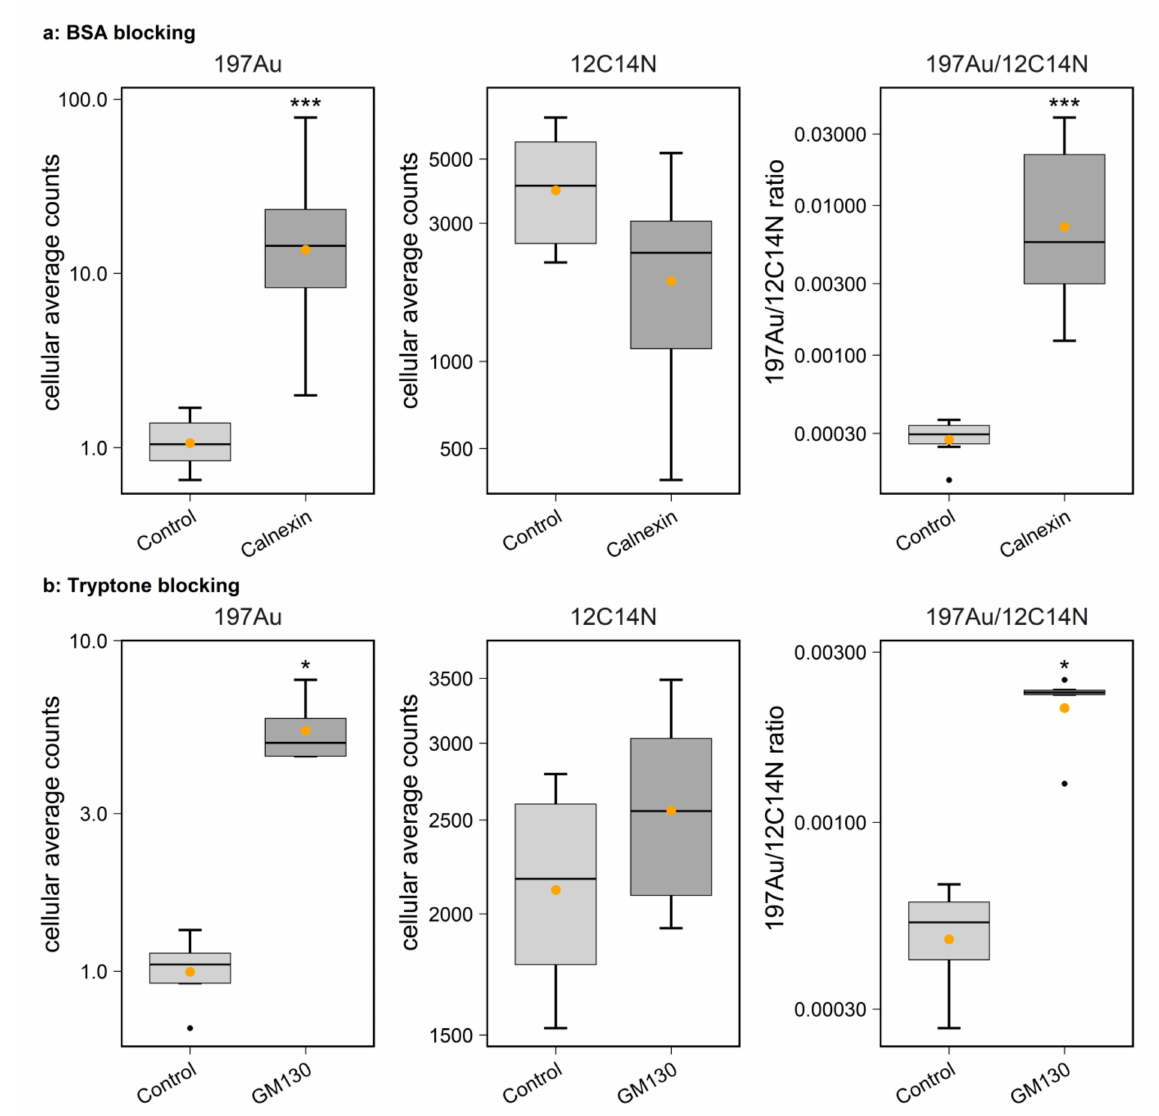
Figure 3. Boxplots show the 6 nm Au_Np labeling intensity of HEK293 organelle markers in com- parison to the control in which no primary antibodies were applied. A significantly higher cellular labeling intensity was detected for both ( a ) bovine serum albumin (BSA) blocking (Wilcoxon rank sum test, N = 6 and 10 for control and calnexin, respectively; p = 2.5 × 10 − 4 , 0.073 and 2.5 × 10 − 4 for 197Au, 12C14N and 197Au/12C14N, respectively) and ( b ) tryptone blocking (Wilcoxon rank sum test, N = 4 and 5 for control and GM130, respectively; p = 0.016, 0.29 and 0.016 for 197Au, 12C14N and 197Au/12C14N, respectively). * p ≤ 0.05, *** p ≤